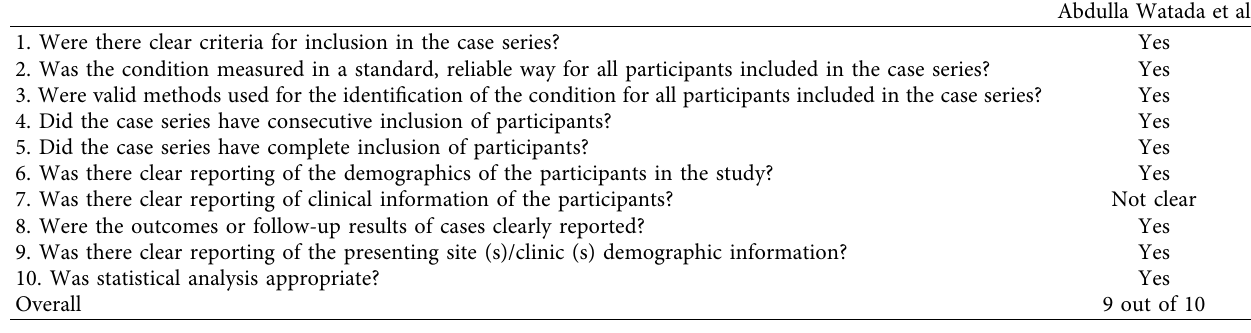
Table 3: Quality assessment based on the JBI tool for case series.